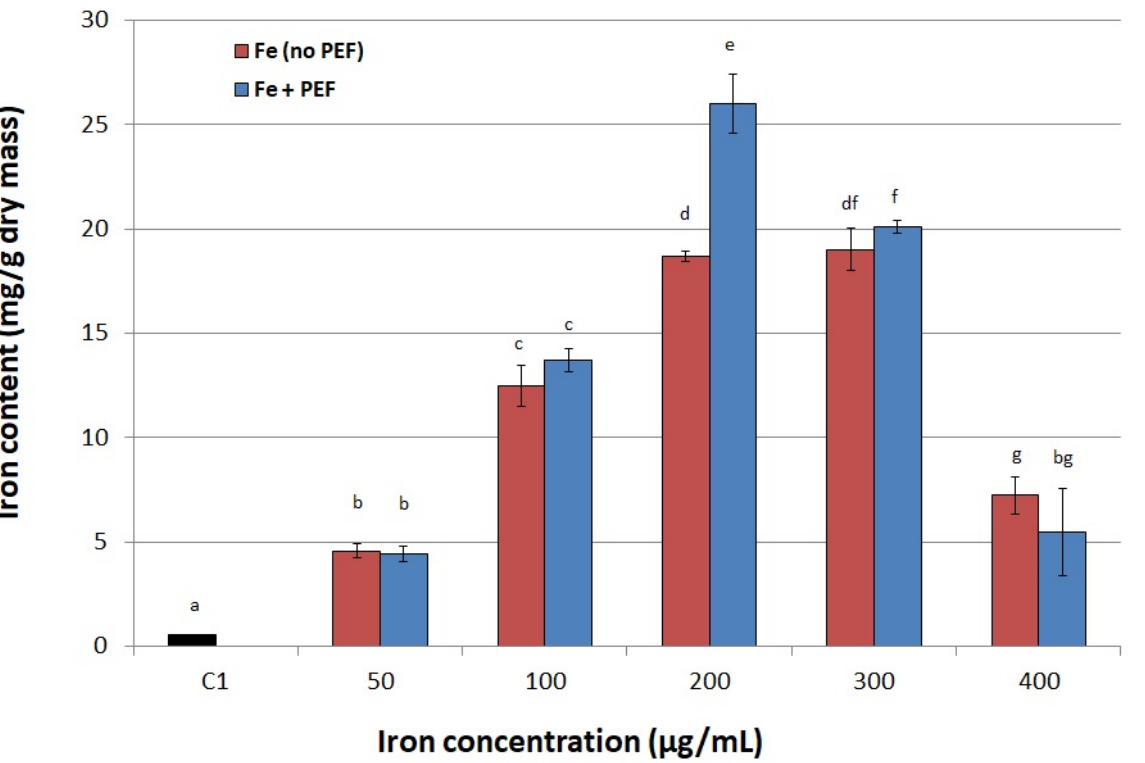
Figure 2. Effect of iron concentration on its accumulation in yeast cells. C1—control culture without iron ions added to the medium and PEF treatment; red bars—cultures not treated with PEF, blue bars—cultures treated with PEF (ferric nitrate, voltage of 1500 V, pulse width of 10 µ s, treatment time 10 min, number of pulses 600, after 20 h of cultivation). Each value is the mean ± standard deviation ( n = 3). Bars with the same letter (a–g) are not significantly different ( p < 0.05).